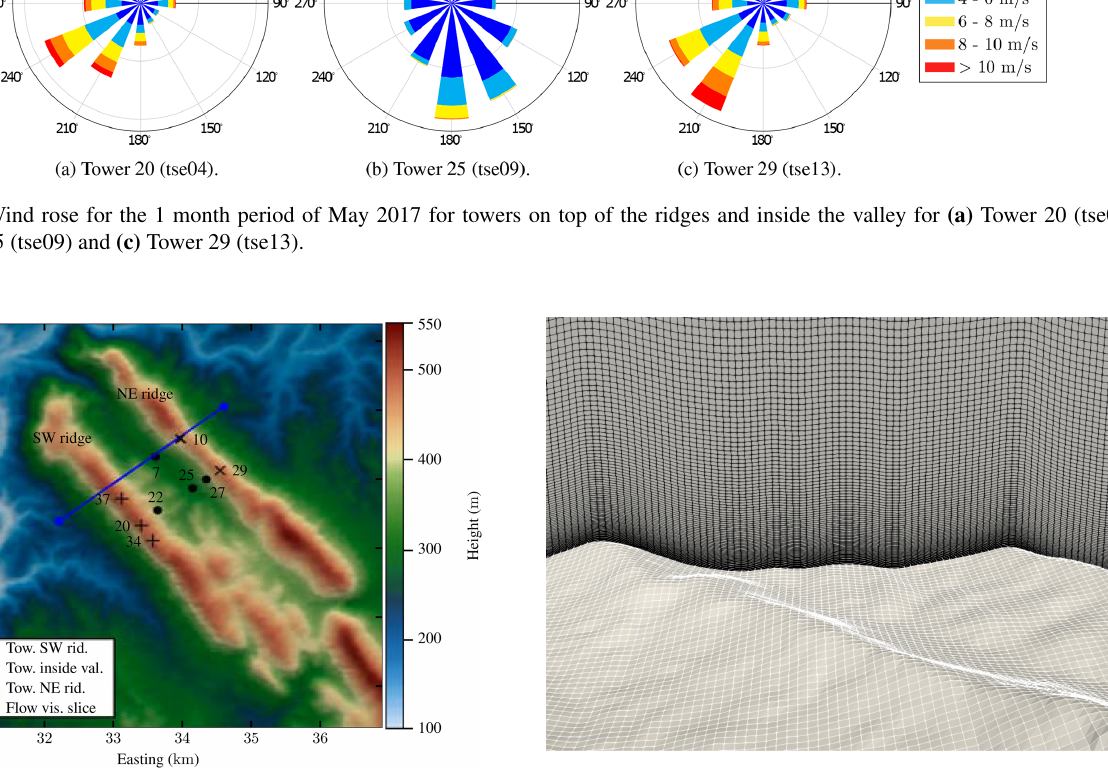
Figure 2. Elevation map and locations of interest at Perdigão. Po- sitions of the measurements towers in the SW ridge group are in- dicated with + symbols, likewise are NE masts marked with × , and the masts in the inside valley group are indicated with black dots. The blue dots and the line represents the flow visualization slice used in Fig. 15. PT-TM06/ETRS89 coordinate system, height above sea level.